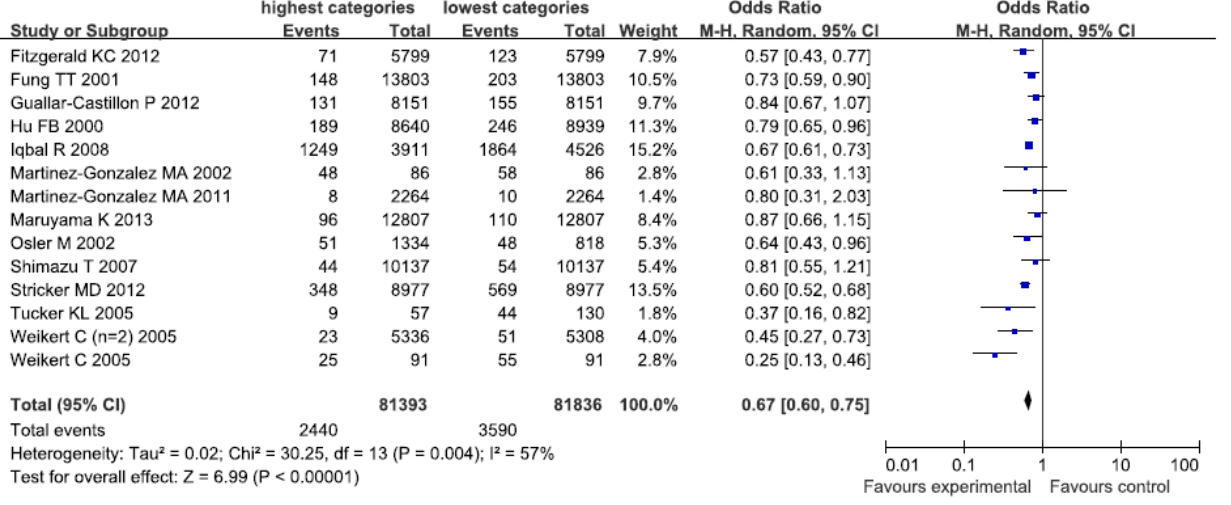
Figure 2. Forest plot of the highest compared with the lowest categories of intake of the healthy/prudent dietary patterns and coronary heart disease (CHD) healthy/prudent dietary patterns and coronary heart disease (CHD) risk.